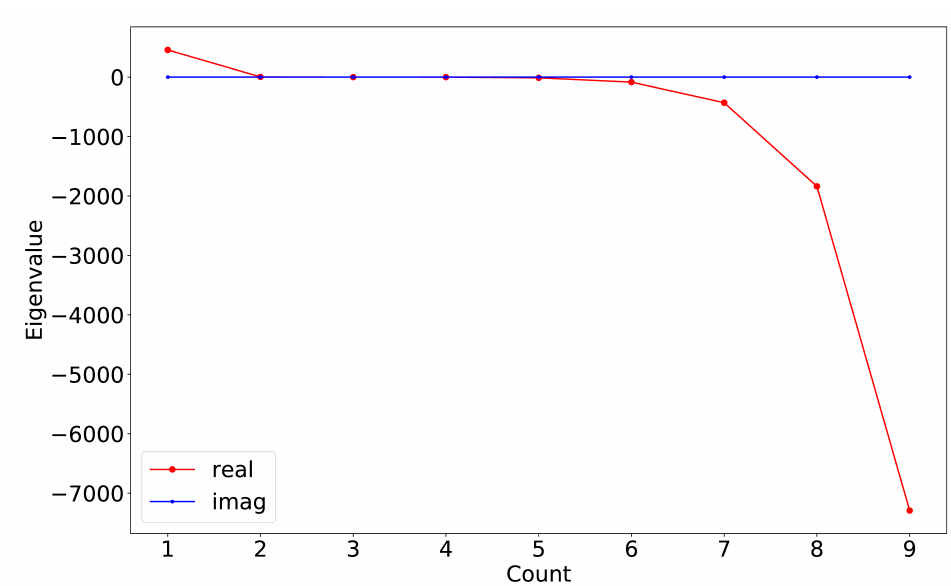
Figure 4. Nine eigenvalues for the 9 9 matrix from Table 4 of Rotunno and Synder, 2008 [32]. Figure 4: Nine eigenvalues for the 9 9 matrix from Table 4 of Rotunno and Synder (2008). As discussed in the × × main text, each eigenvalue is associated with a pair of solution components. A positive eigenvalue yields a pair As discussed in the main text, each eigenvalue is associated with a pair of solution of exponentially growing and decaying components, while a negative eigenvalue leads to oscillatory components.